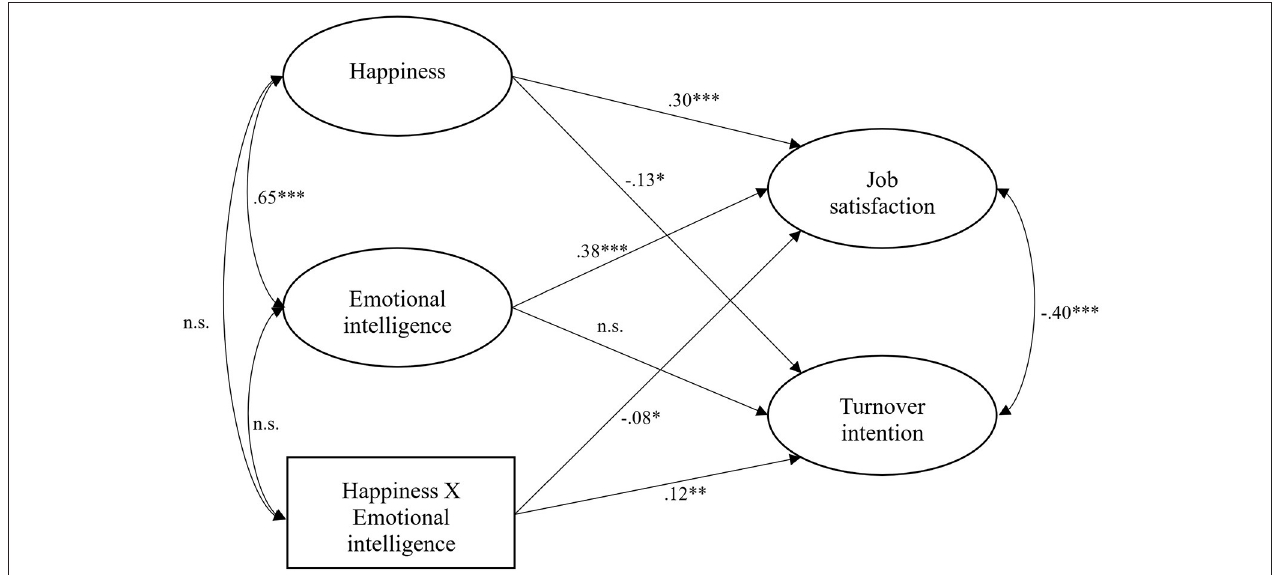
FIGURE 1 | Standardized coefficient estimates of hypothesized SEM. Covariates (i.e., sex, gender, educational level, and teaching experience) and items included in the latent variables have been omitted in the figure representation; n.s., non-significant. * p < 0.05, ** p < 0.01, *** p < 0.001.